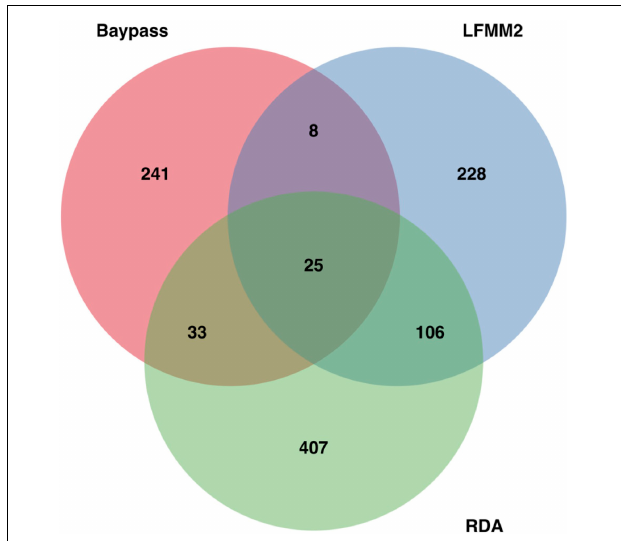
FIGURE 5 | Venn diagram representing the number of SNPs putatively associated to environmental variables detected in the environmental association study. In total, Baypass detected 307 SNPs putatively under selection, while LFMM2 and RDA respectively detected 367 and 584 SNPs. This Venn diagram was produced using the library VennDiagram in